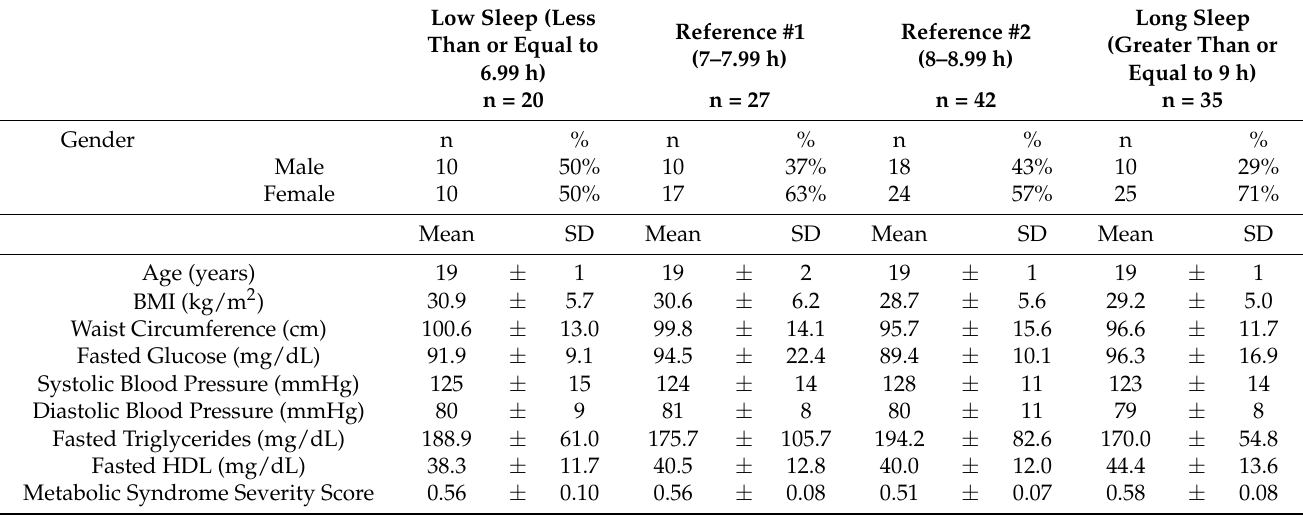
Table 4. Metabolic syndrome participant